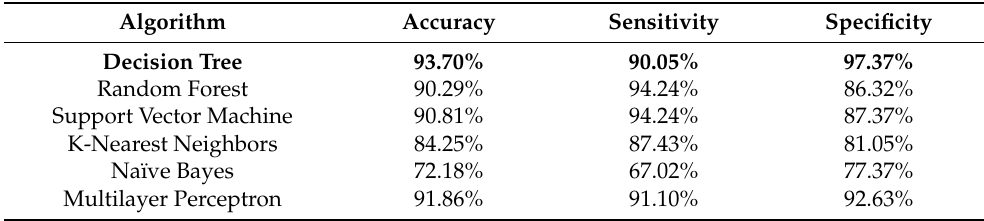
Table 10. Comparative